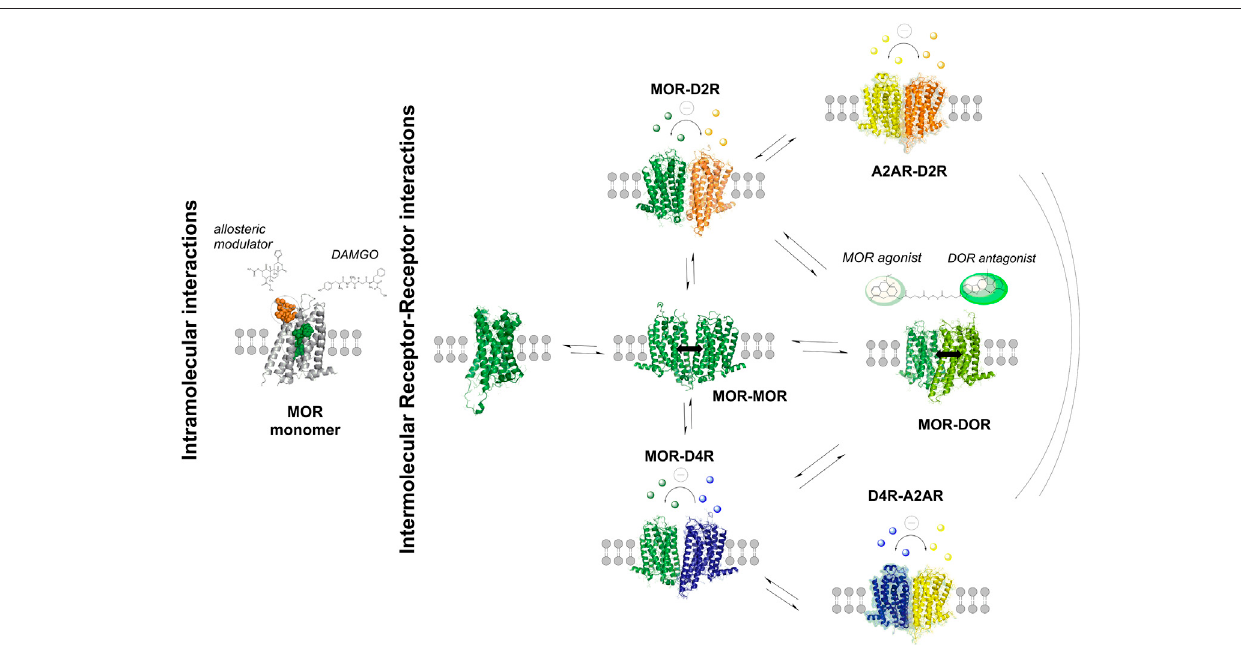
FIGURE 1 | A propose model on the existence of MOR, D2R and A2AR homo-and heteroreceptor complexes in balance with each other in the ventral striatal- pallidal GABA antireward neurons, shown as dimers. The MOR monomer and its intramolecular interactions are shown in the left panel. The orthosteric MOR receptor binding site is indicated in yellow to which e.g., the MOR agonist DAMGO (in green) can bind. The allosteric MOR binding site is shown in yellow. The intermolecular receptor-receptor interactions in adenosine, dopamine and opioid homo-and heteroreceptor complexes, shown as dimers, are indicated in the right panel. The balance between the oligomers is indicated by two arrows perpendicular to each other. It should be noted that A2R-dopamine D4 receptor (D4R) heteroreceptor complexes also exist in the rat forebrain, as demonstrated by the proximity ligation assay (Borroto-Escuela and Fuxe, 2019; Borroto-Escuela et al., 2020a). They were found insubstantial densities intheprefrontalcortex,especiallyinthesomaticmembraneoftheinternal pyramidalcell layerV,and inthedorsalhippocampus, especially inthepyramidalcelllayer(Borroto-EscuelaandFuxe,2019).Theyalsoexistinhighdensitiesinthenucleusaccumbensanddorsalstriatumincludingbothstriosomeand matrix compartments. Moreover, the D4Rs in the cortical regions have a role in cognition (Furth et al., 2013) that may be modulated by A2AR through the demonstrated A2AR-D4R heteroreceptor complexes in the prefrontal cortex and the hippocampus. Whether these receptor complexes have a role in cocaine and morphine use disorders, requires further